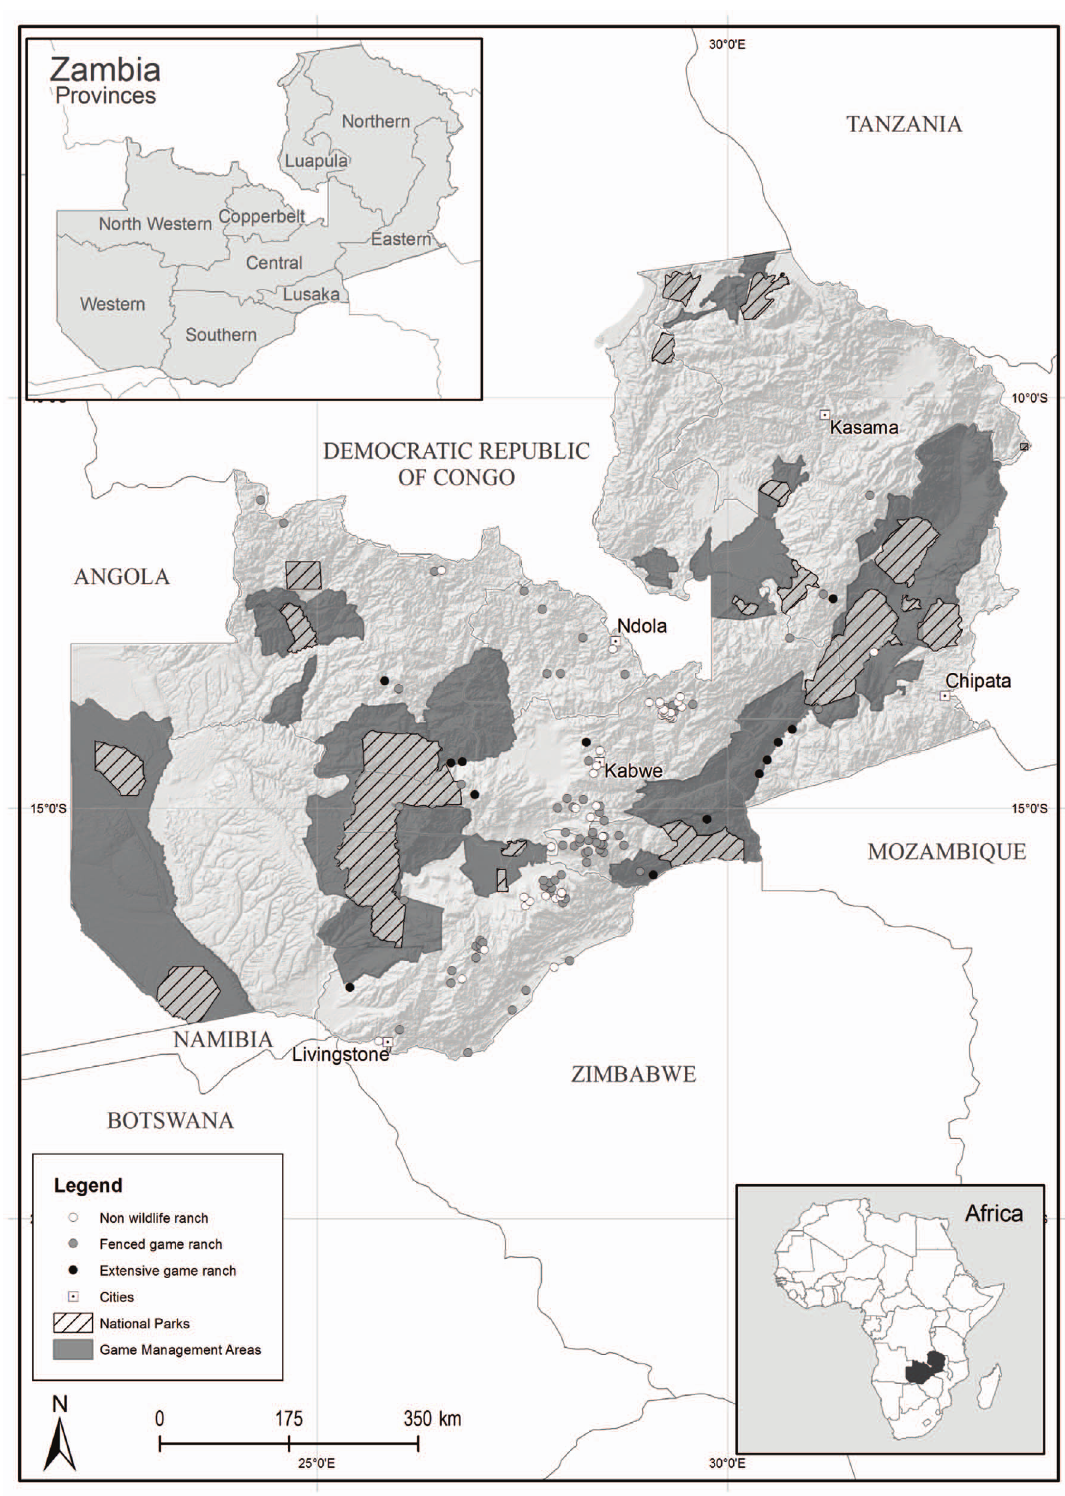
Figure 1. Location of properties of game ranchers and non-game ranchers surveyed. doi:10.1371/journal.pone.0081761.g001 production is not permitted (Table 2). Of fenced wildlife ranches, 54.0% utilized wildlife commercially, most commonly via trophy hunting, sale of venison and live wildlife, ecotourism and the sale